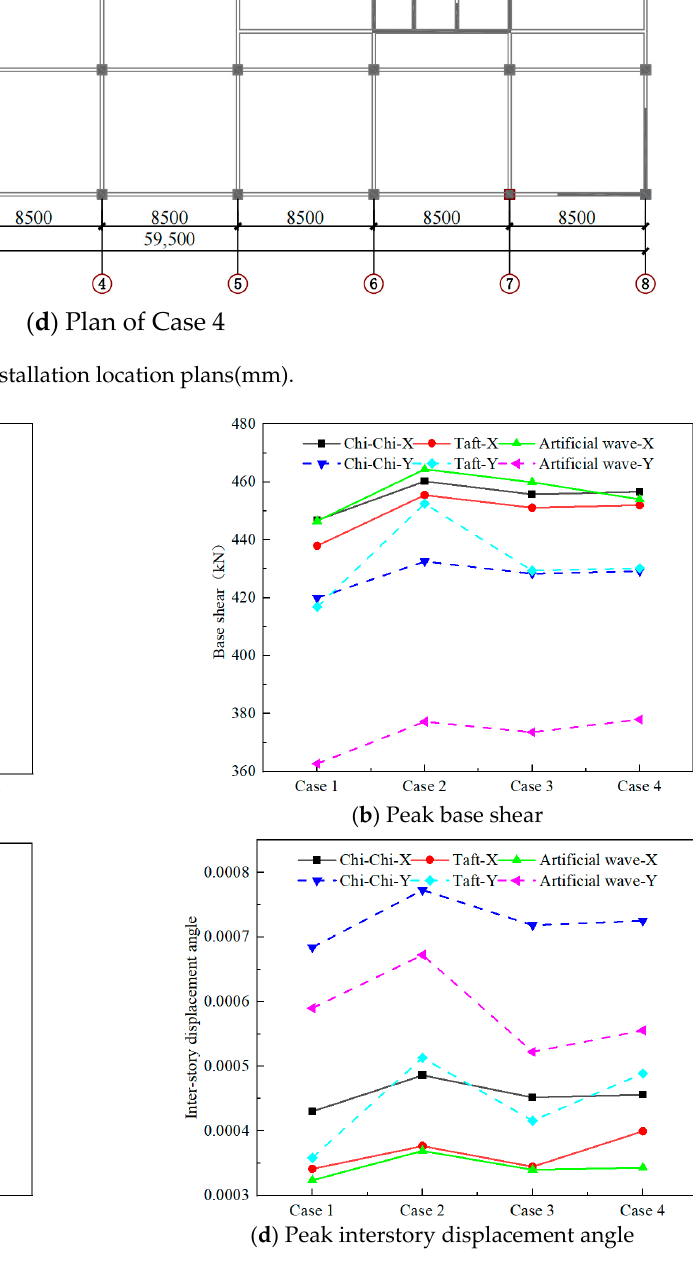
Figure 10. Results of frequent-earthquake time-history analysis.